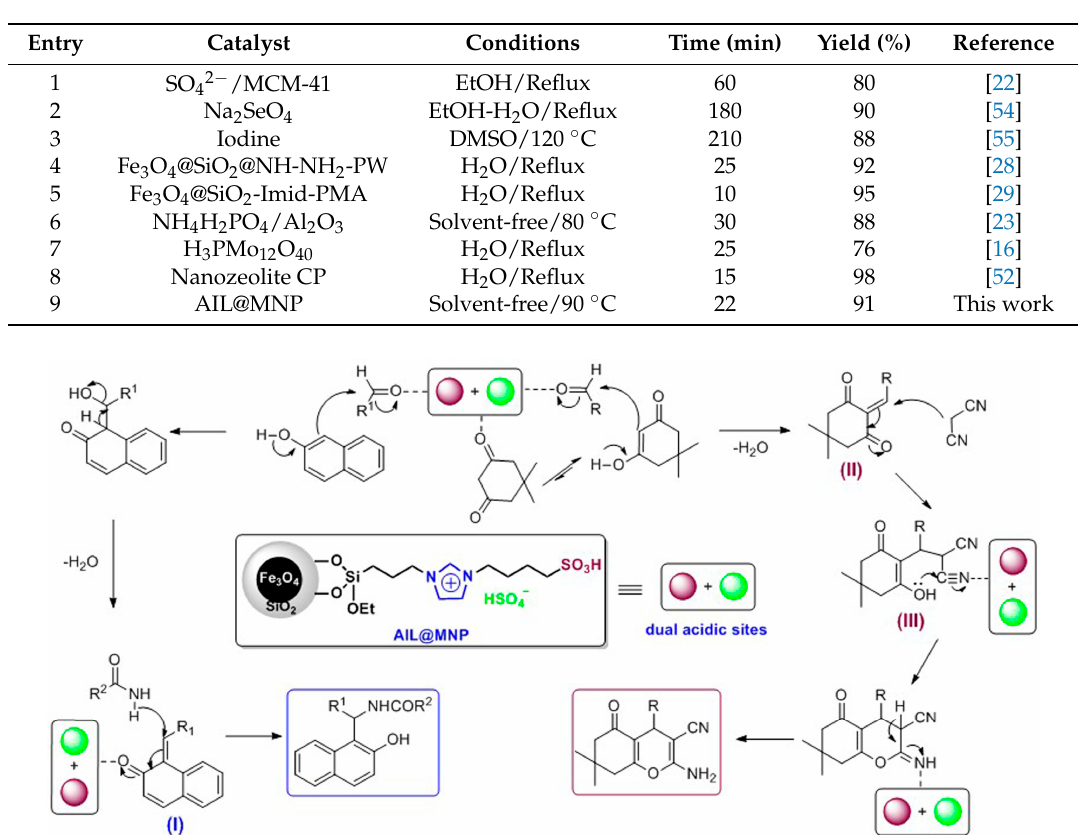
Scheme 3. Plausible mechanisms for the synthesis of amidoalkyl naphthols and